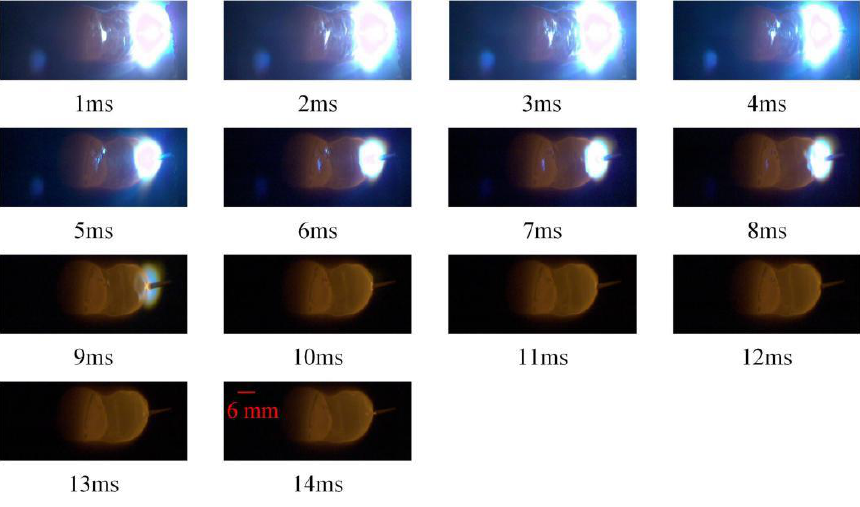
Figure 5. Welding current waveform of cold-metal-transfer (CMT) procedure.